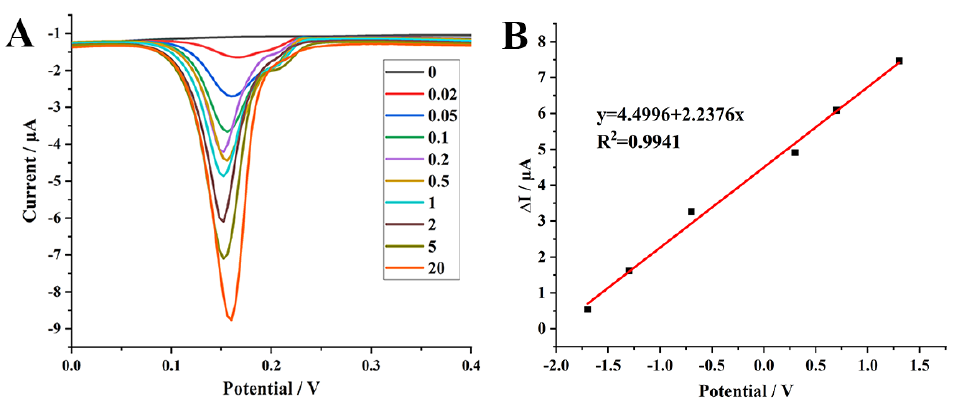
Figure 4. ( A ) differential pulse voltammetry (DPV) curves recorded on AP1/N–Cu–MOF/GCE with the successive addition of DON in PBS (1 mmol L − 1 , pH 5.0). ( B ) Calibration curves of DON with the successive addition of DON in PBS (1 mmol L −1 , pH 5.0). ( B ) Calibration curves of DON with AP1/N–Cu–MOF/GCE as the working electrode. ∆ I = I p − I p0 , where I p0 is the peak current for the AP1/N–Cu–MOF/GCE as the working electrode. ΔI = I p −I p0 , where I p0 is the peak current for the blank PBS and I p represents the peak current for PBS containing DON. blank PBS and I p represents the peak current for PBS containing